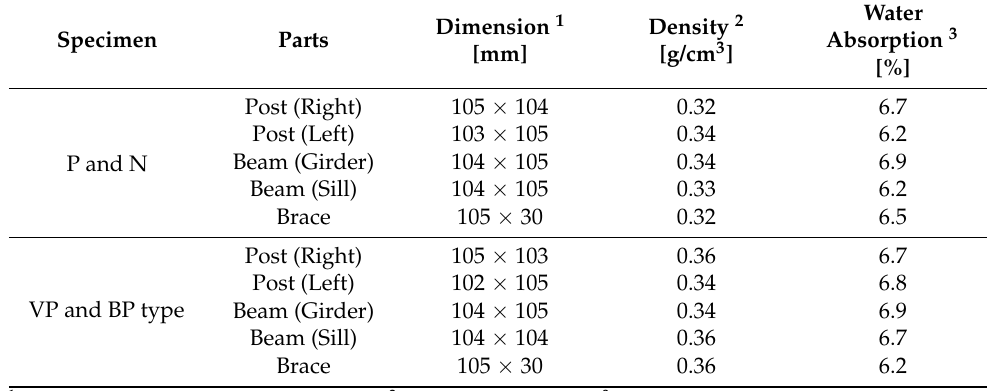
as a percentage of weight.